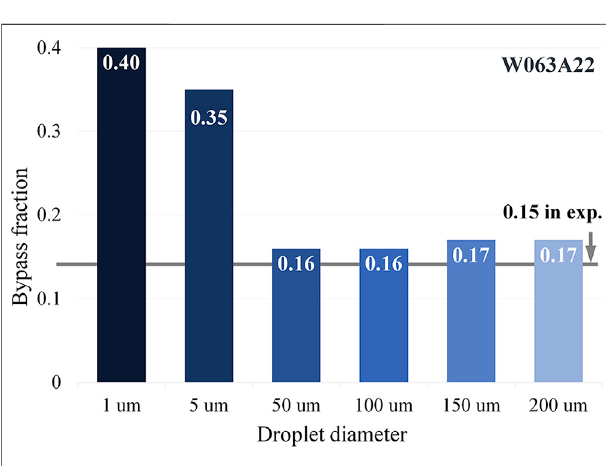
FIGURE 10 | Bypass fraction versus droplet diameter